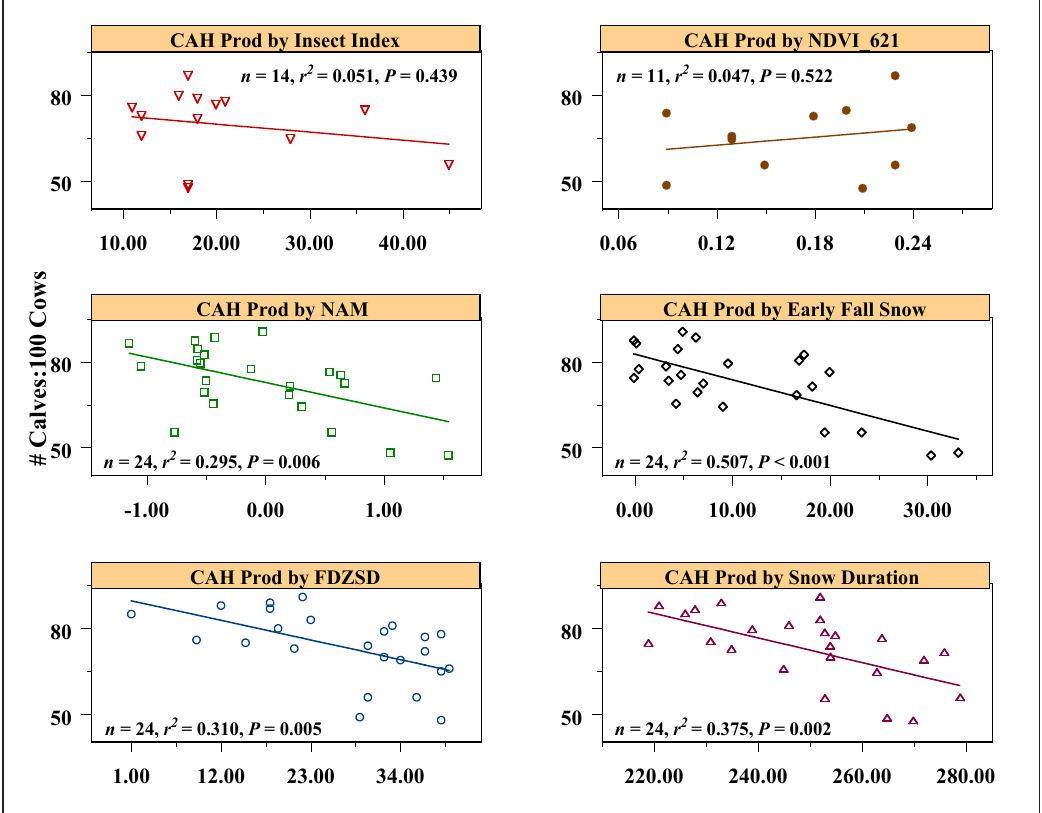
Fig. 2. Potential limiting factors of net productivity in the Central Arctic Herd as estimated ~1 week after the peak of calving, including a summer insect severity index from the previous year (# harassment days from 15 June–15 August), NDVI_621 from the previous year, NAM winter (Nov.–April) index, early fall (15 Aug.–30 Sept.) snow deposition (cm) from the previous year, first day of zero snow depth in the spring (FDZSD; 10 May = 1), and snow duration from the previous fall to spring (no. days), 1977–2002.